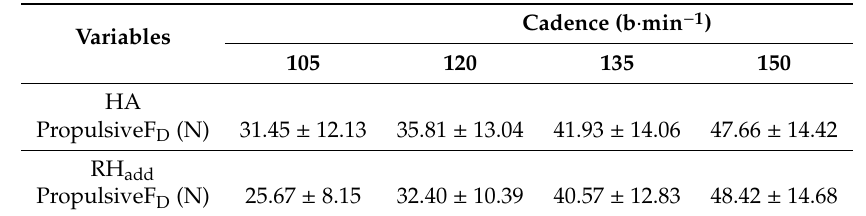
Table 1. Descriptive statistic (Mean ± SD) of the propulsive peak force of dominant limb in two head-out water exercises at di ff erent cadences.